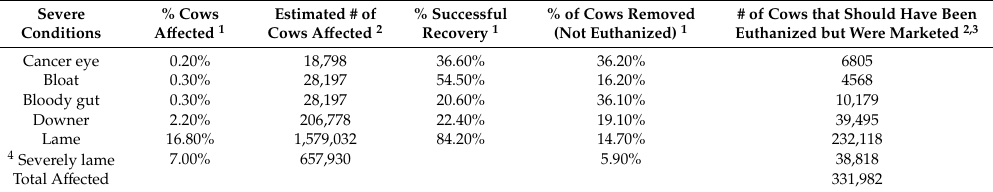
Table 1. Estimates of the number of dairy cattle a ff ected by, sold with, and died with severe conditions based on data reported in the 2014 National Animal Health Monitoring System (NAHMS) Health and Management Practices on U.S. Dairy Operations report [4]. Number of cows a ff ected based on NAHMS estimates applied to the total number of lactating cows (9,399,000 head) in the US in 2018 [18]. Severe % Cows Estimated # of % Successful % of Cows Removed # of Cows that Should Have Been Conditions A ff ected 1 Cows A ff ected 2 Recovery 1 (Not Euthanized) 1 Euthanized but Were Marketed 2,3 Cancer eye 0.20%